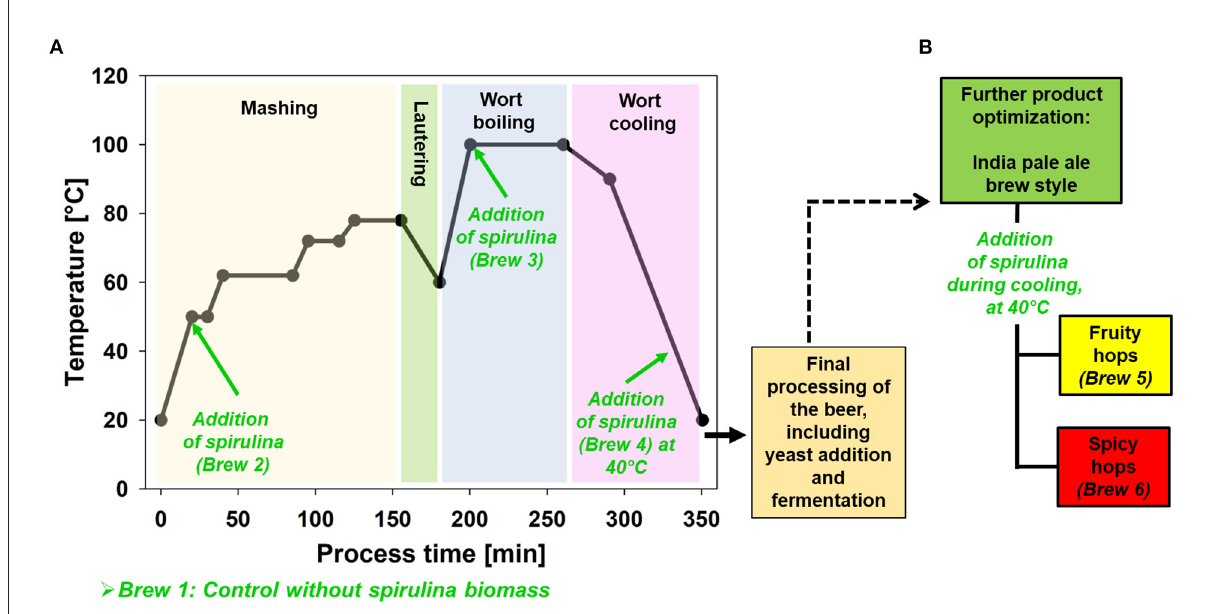
FIGURE1 Process scheme. (A) Addition of spirulina biomass in the reference recipe (mild pale ale). (B) Further product optimization within India pale ale brew style.